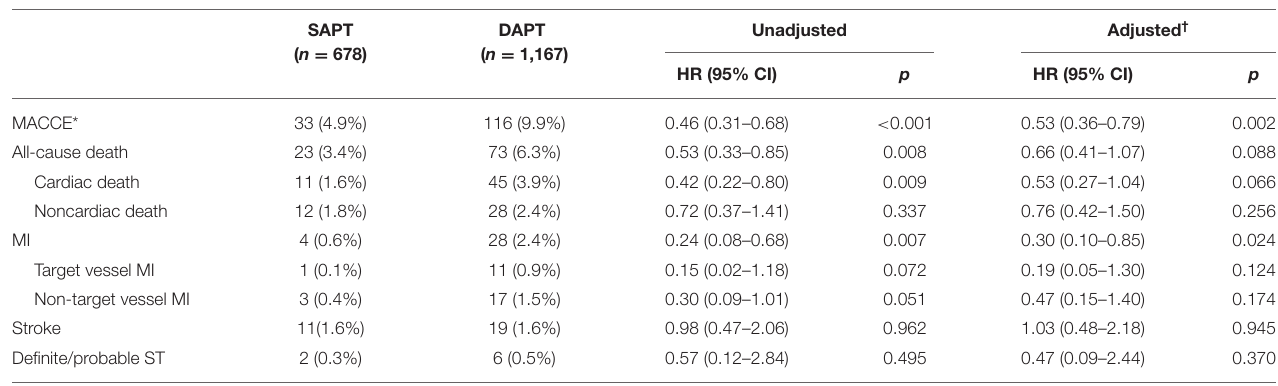
TABLE 4 | Comparison of clinical outcomes in patients with complex